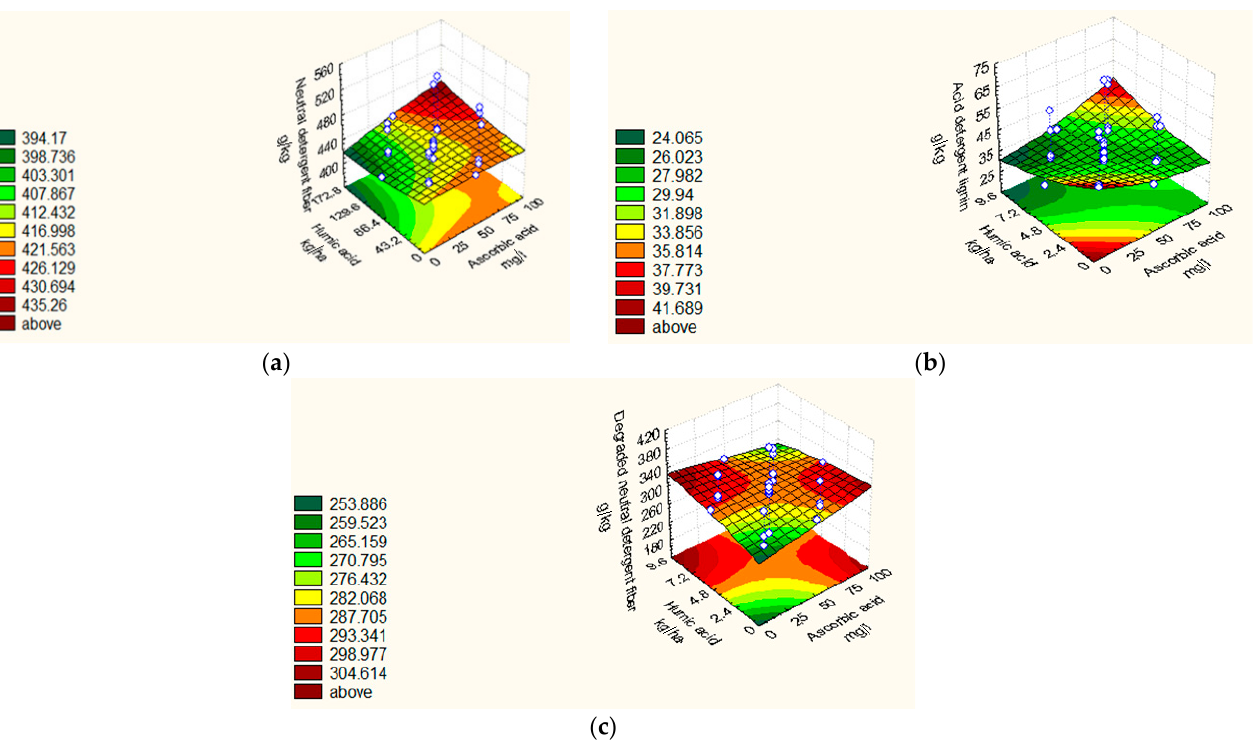
in 2019/20 as affected by AC and HA at the central levels of PF and AA. ( b )